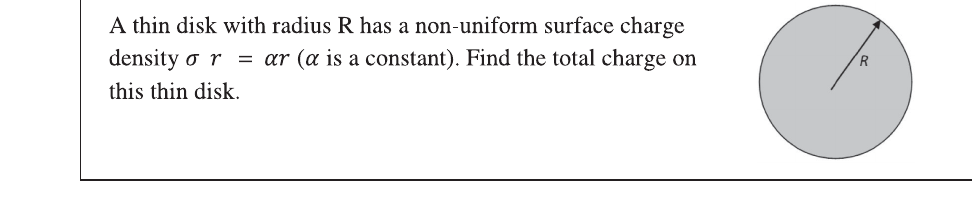
FIG 3. Example of a conventional problem.